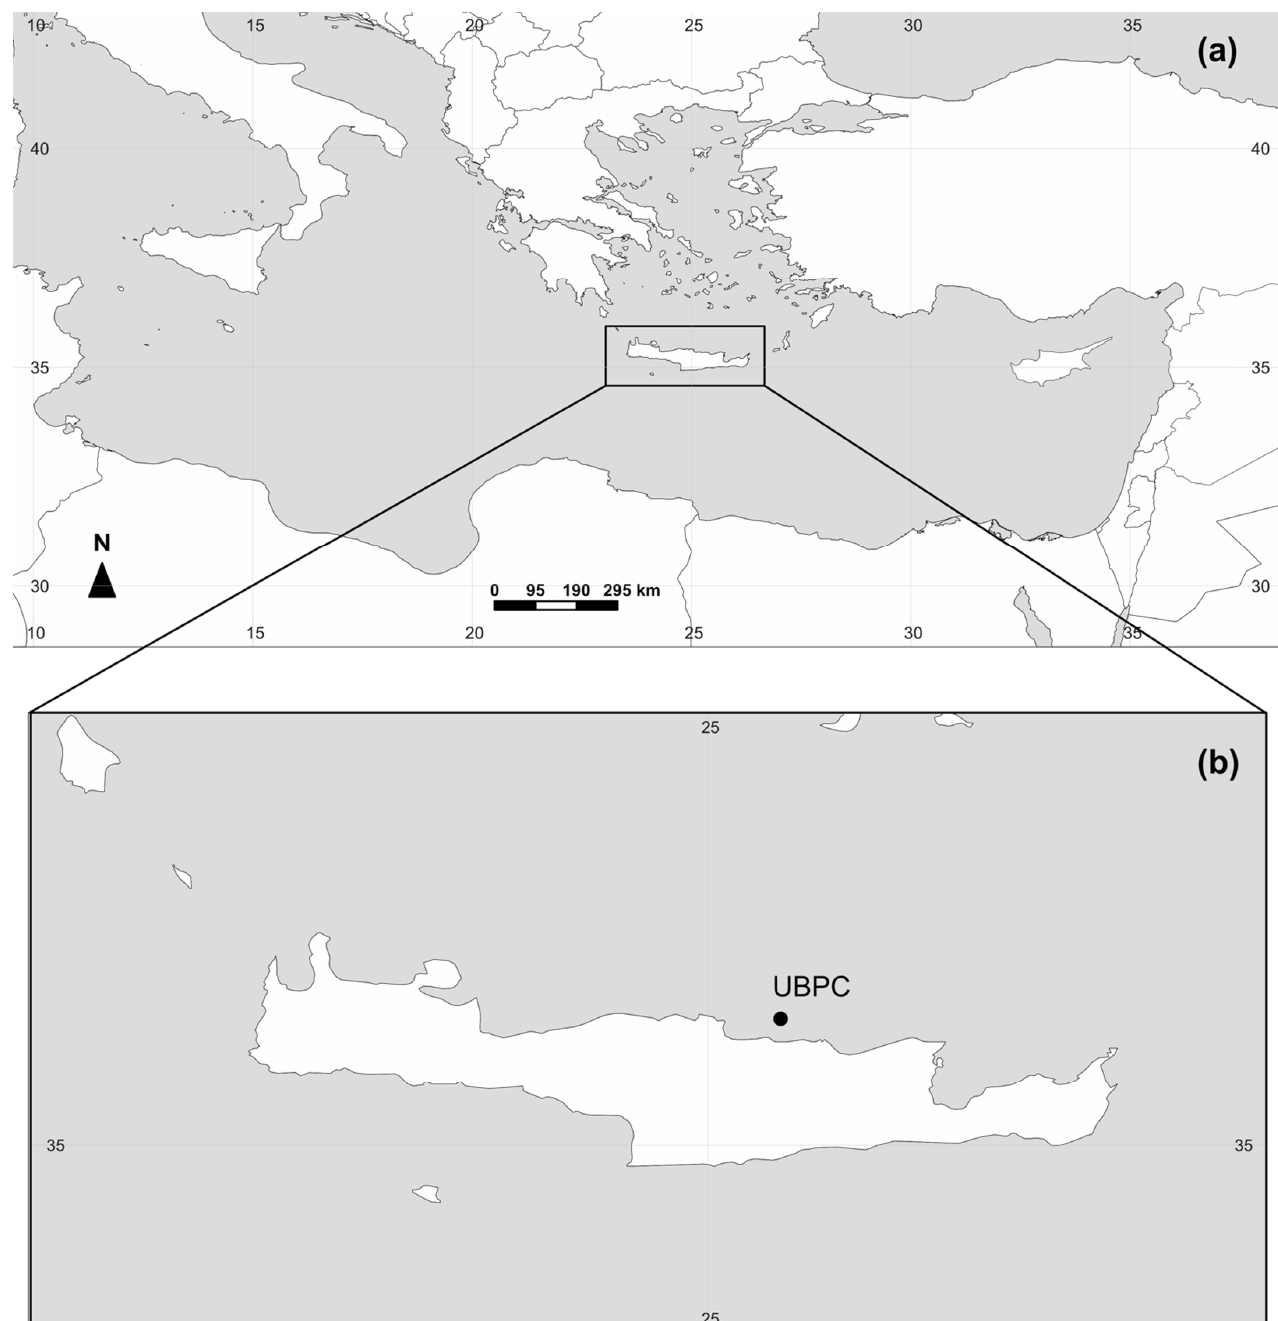
Figure 1. ( a ) Map of the Eastern Mediterranean Sea. ( b ) Location of the Underwater Biotechnological Park of Crete (UBPC) (red arrow), almost 2 km offshore from the northern coast of Crete in Greece.